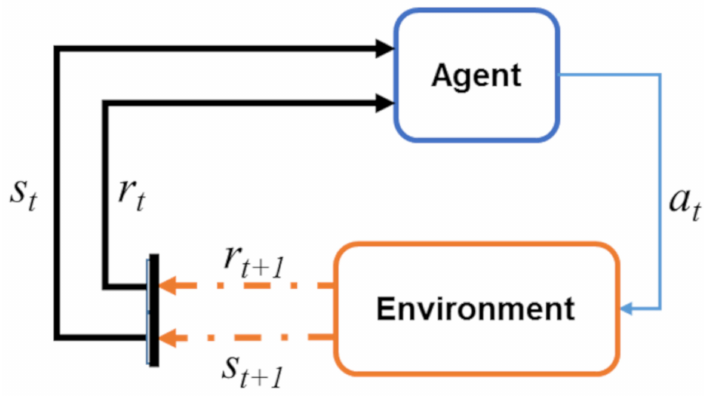
Figure 1. Reinforcement Learning